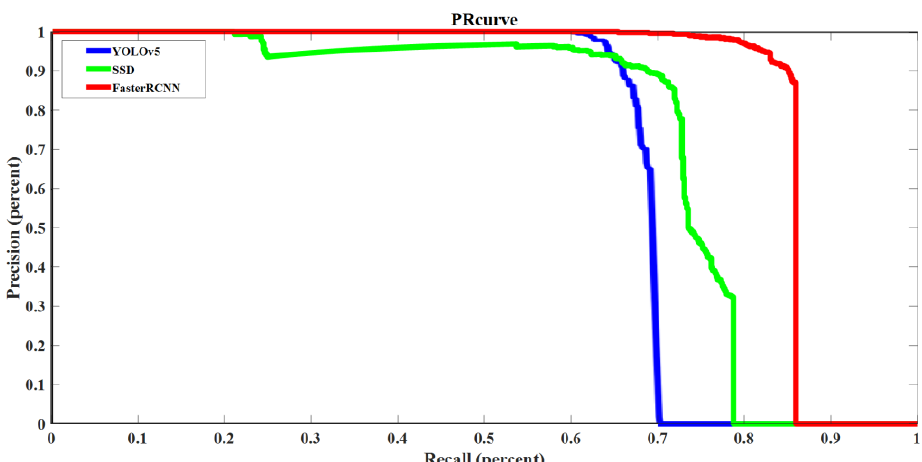
Figure 5. Deep learning models’ PR curve for testing data set one.